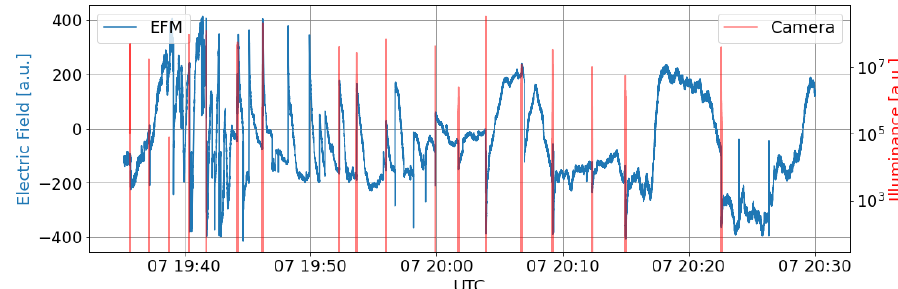
Figure 15. An example of measurements with the EFM compared with records of lightning captured on the camera.